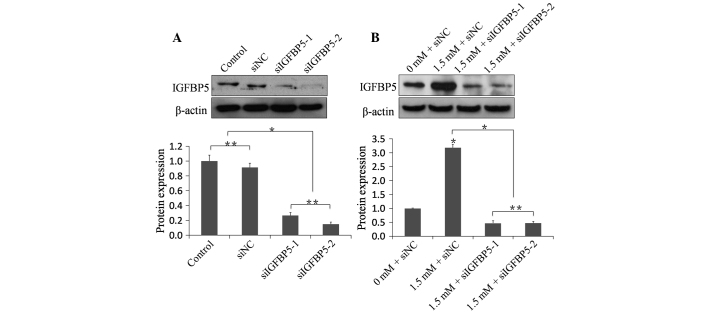
siIGFBP5 silences the protein expression of IGFBP5 in NRVMs. (A) Nonspecific silencing control lane showed no effect of siNC in NRVMs 48 h post-transfection. siIGFBP5-1 and siIGFBP5-2 demonstrated efficient knockdown of IGFBP5 at the protein level. (B) The knockdown efficacy of siIGFBP5 was not affected following treatment with MA. An antibody against β-actin was used as the loading control. The data are presented as the mean ± standard deviation (n=6; *P<0.01, **P>0.05). MA, methamphetamine; NRVMs, neonatal rat ventricular myocytes; IGFBP5, insulin-like growth factor binding protein-5; si, small interfering.